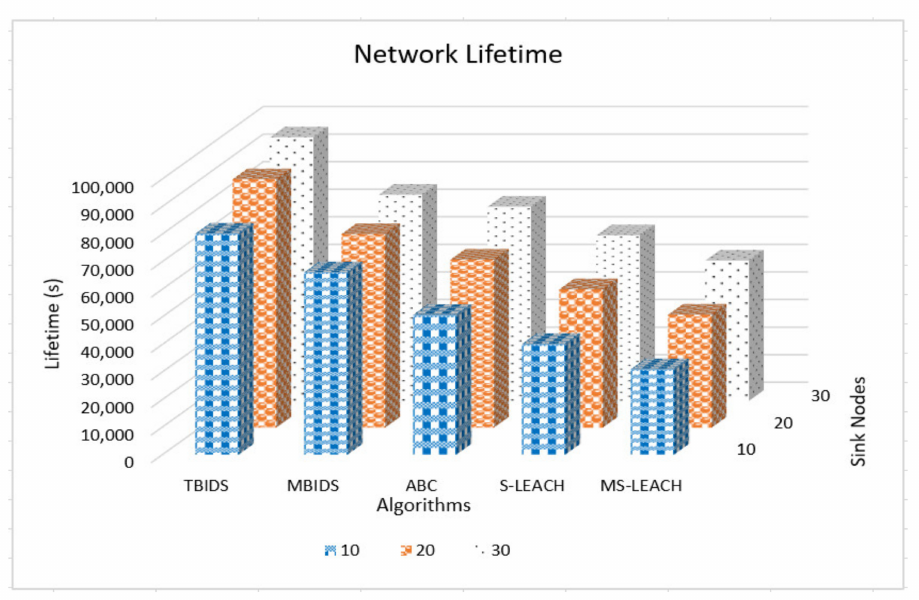
Figure 17. Lifetime for large-scale networks, 8000 sensor nodes, with 10, 20, and 30 sink